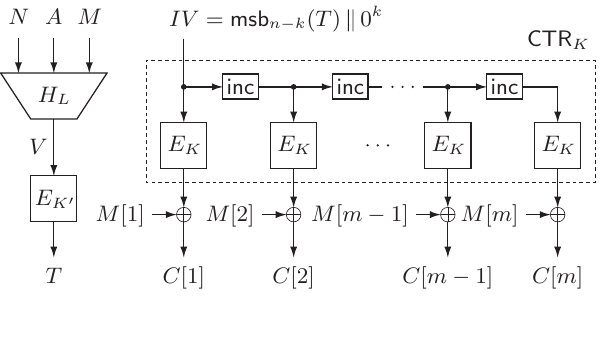
Figure 3: The encryption algorithm of